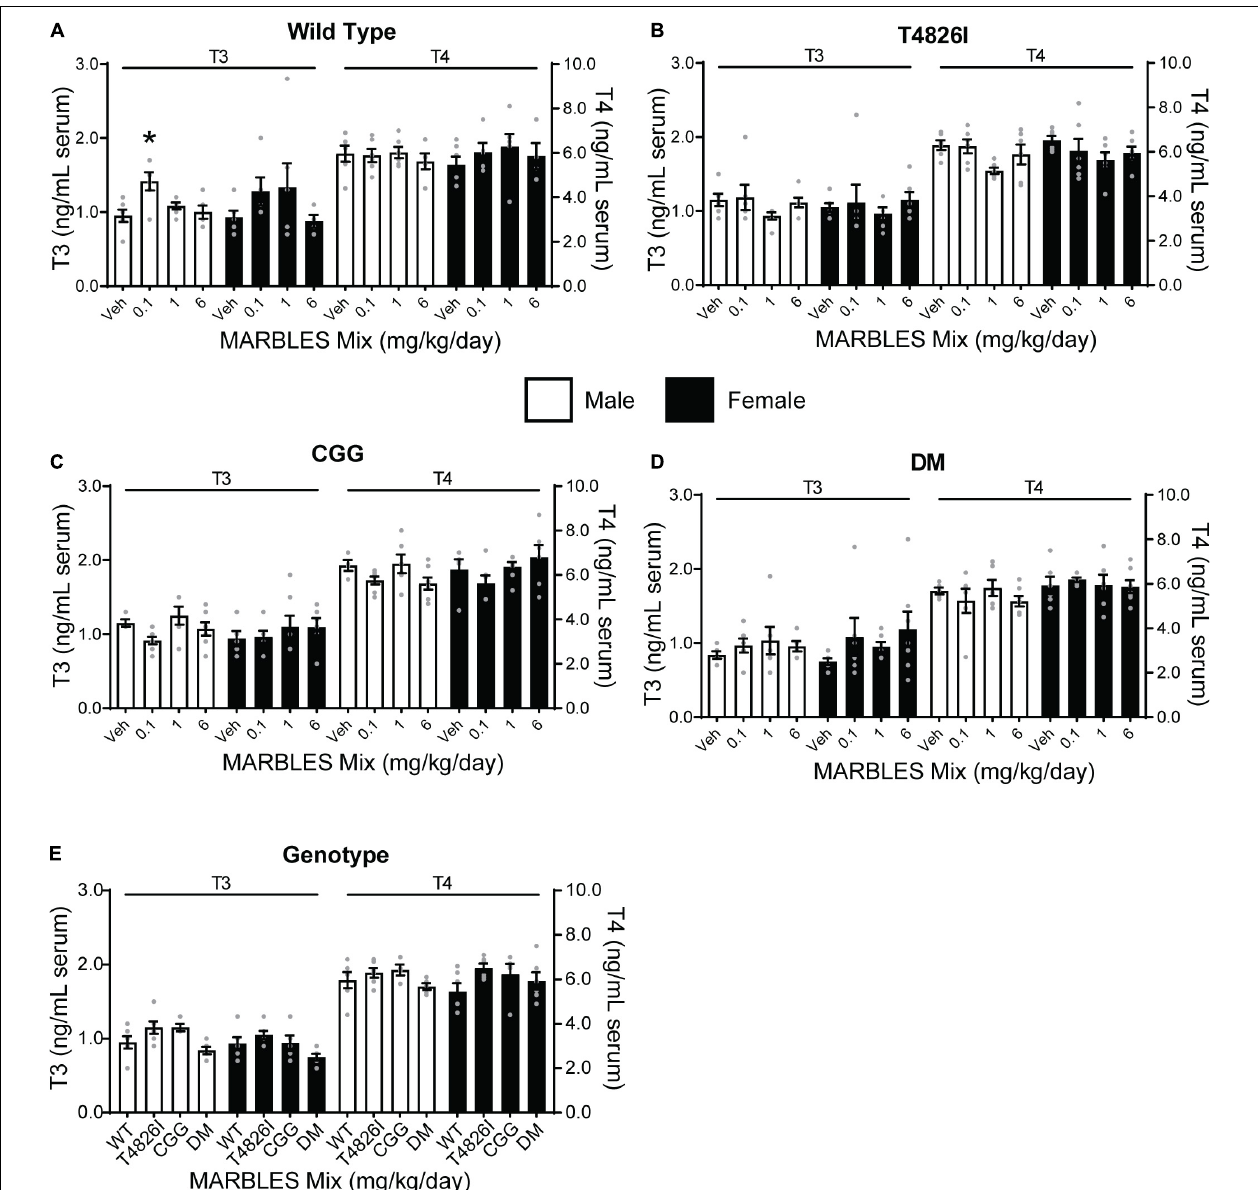
FIGURE 7 | Developmental PCB exposure and genotype had had minimal to no effect on thyroid hormone levels. (A–D) The serum levels of triiodothyronine (T3) and thyroxine (T4) in (A) WT, (B) T4826I, (C) CGG, and (D) DM mice developmentally exposed to varying doses of the MARBLES PCB mix in the maternal diet. (E) T3 and T4 levels in vehicle control mice of each genotype. Data presented as mean ± SEM ( n = 4–7). * Indicates significant difference between sex-matched vehicle control at p < 0.05 as determined using a one-way ANOVA or Kruskal Wallis test with post hoc Holm-Sidak’s multiple comparisons test or Dunn’s test,